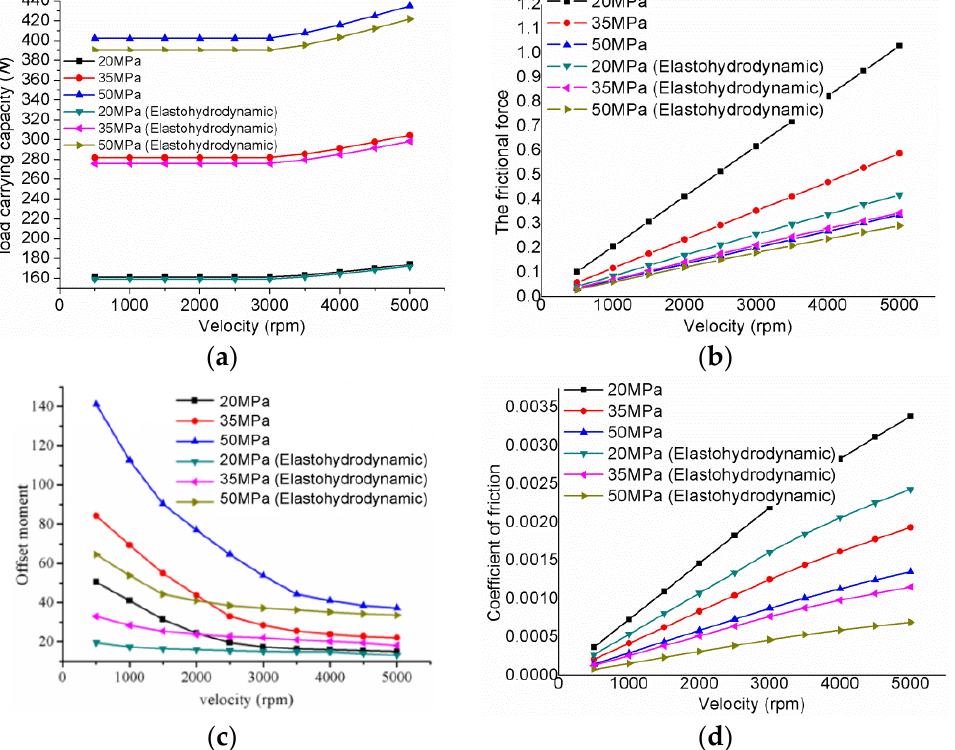
Figure 18. Effect of the velocity on the lubrication property. ( a ) Carrying capacity; ( b ) friction force; ( c ) offset load moment; ( d ) friction coefficient.